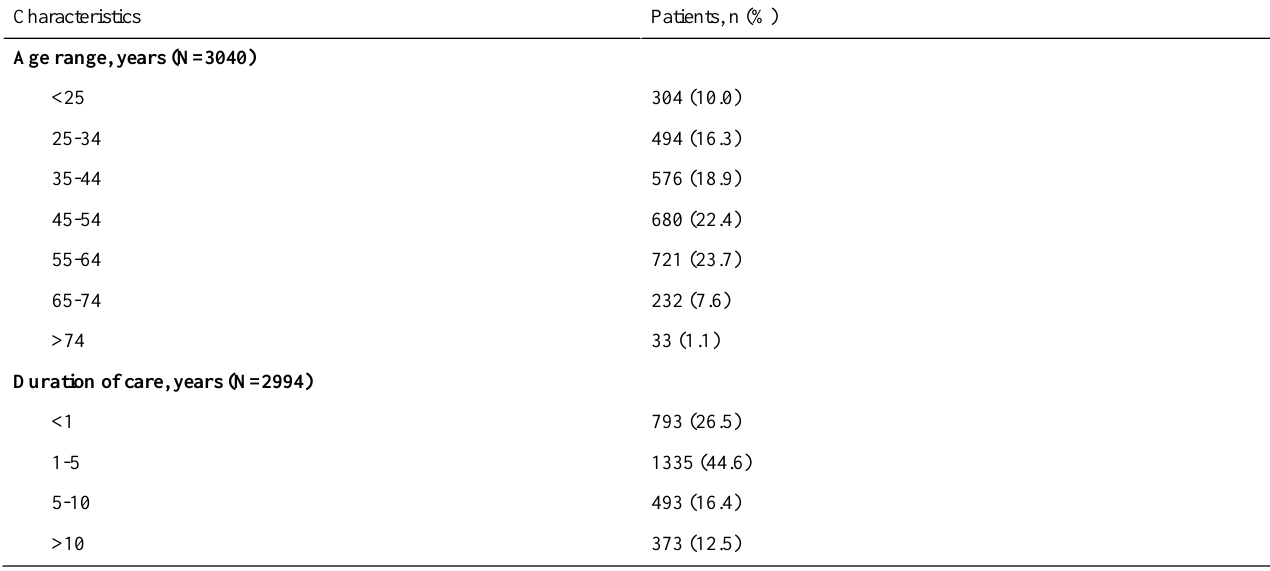
Table 1. Characteristics of the patients included in the study.